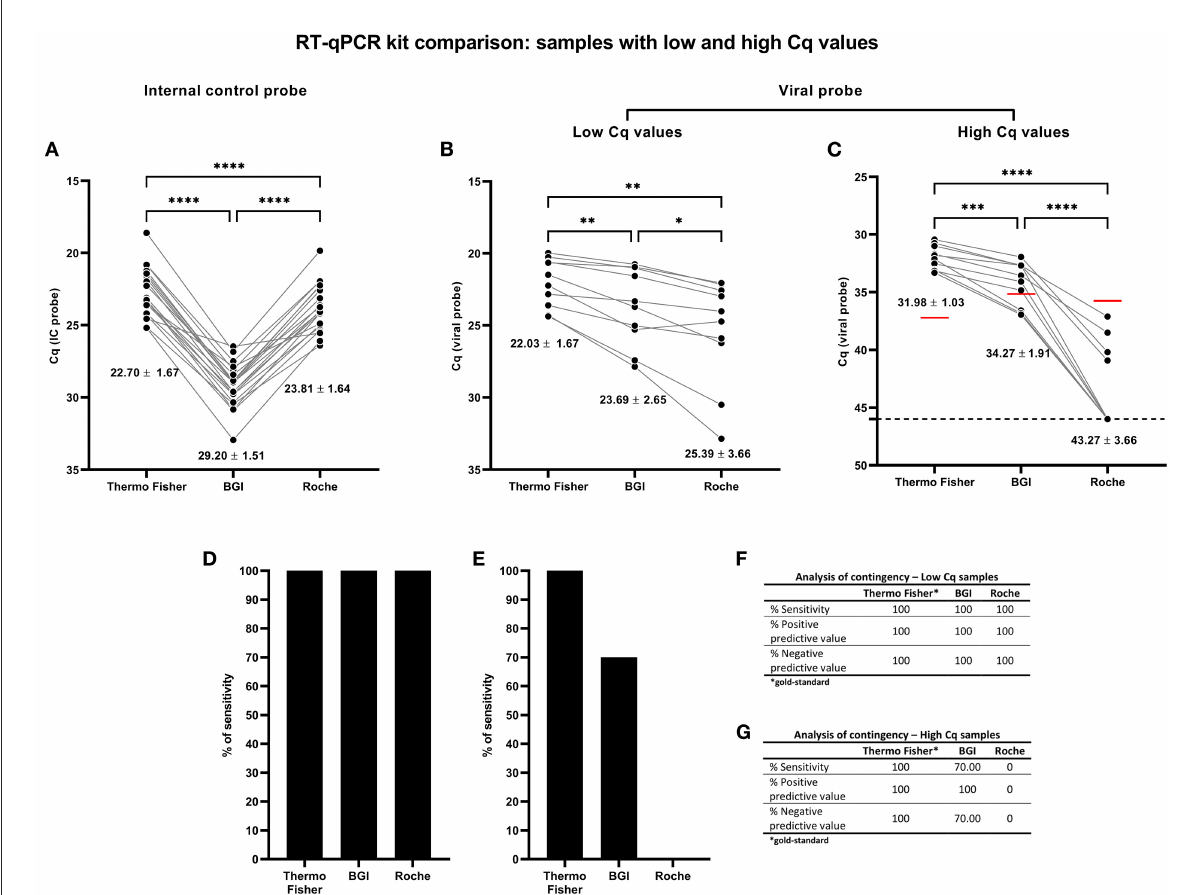
FIGURE5 Comparative analysis for detecting SARS-CoV-2 from NPS samples with low (Cq < 30) and high (Cq > 30) viral probe Cq values using the three RT-qPCR kits. The comparison was made from the same NPS sample loading the optimized volume of total RNA extracted (2 µ l). Each spot for each RT-qPCR kit is a different analyzed sample. For graphs (A–C) , the lines connecting the points indicated the paired result obtained from the same sample assessed by the different RT-qPCR kits; the numbers below each group of points represent the mean Cq value and the standard deviation (mean ± SD). Cq = 46 denotes no amplification (No Cq) and is represented with a broken line. (A) Paired Cq analysis for the IC probe (RNase P or β -actin) amplification values obtained by RT-qPCR for each sample assessed. Paired Cq analysis for the SARS-CoV-2 viral probe (ORF1ab or RdRp) amplification values obtained by RT-qPCR for samples with (B) low Cq value (Cq value < 30, high viral load) and (C) high Cq value (Cq value > 30, low viral load). In graph (C) , the horizontal red lines indicate the Cq cut-off determined for the viral probe (Figure 4) of each RT-qPCR kit respectively. Comparison of RT-qPCR kits sensitivity percentage assessed for samples with (D) low and (E) high viral probe Cq values for all three RT-qPCR kits. Contingency analysis for all three RT-qPCR kits for samples with (F) low and (G) high viral probe Cq values for all three RT-qPCR kits. For statistical analysis, paired two-way ANOVA was applied ( n = 10 NPS samples with Cq value < 30; n = 10 NPS samples with Cq value > 30). * p < 0.05; ** p < 0.01; *** p < 0.001; **** p < 0.0001.